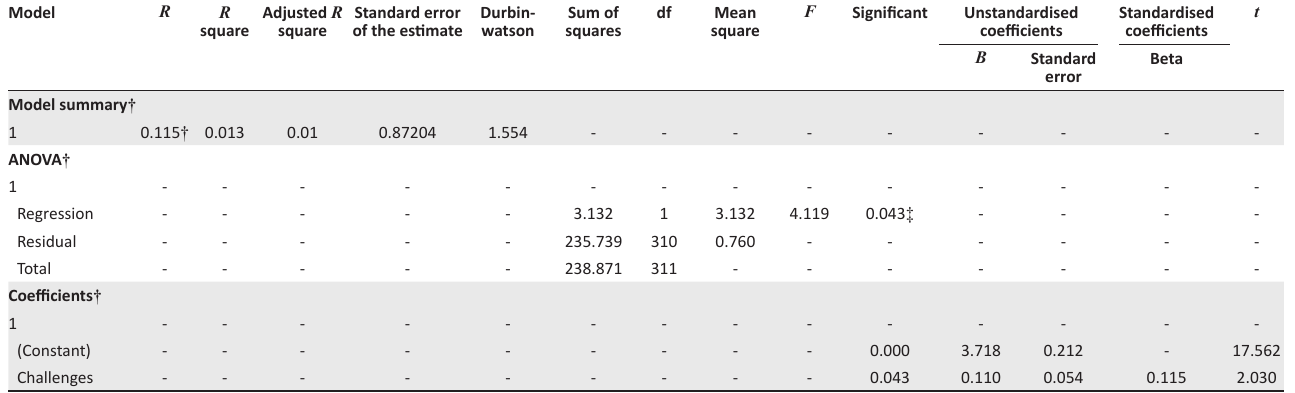
TABLE 7: Regression analysis: Challenges and digital media practices. Model